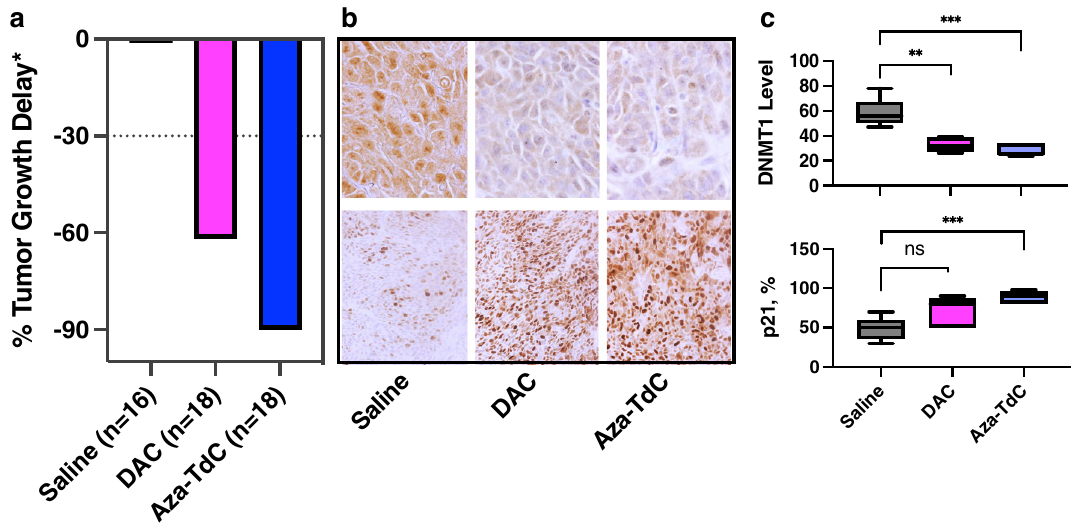
Figure 4. Tumor growth inhibition and modulation of DNMT1 and p21 by DNMTi treatment in HCT116 DNMT1 +/+ xenograft models. ( a ) Tumor growth delay (see “Methods”) by DAC and aza-TdC relative to the saline treatment. Dotted line indicated 30% of tumor growth inhibition. *The maximal tumor growth delays in DNMT1 +/+ tumors were observed at day 12 and day 18 of DAC and aza-TdC treatment, respectively. ( b ) Representative expression of DNMT1 and p21 from the tumor samples treated with DAC and aza-TdC. Magnification, ×200. ( c ) Modulation of DNMT1 (upper panel) and p21 (lower panel) by treatment in an average of 5 mouse tumor samples relative to that of saline treatment. ** P < 0.01; *** P < 0.001. The solid band in the Box- Whisker plot is mean, top and bottom borders of the plot represent 25% of data greater or less than that value, and the whiskers are maximal and minimal